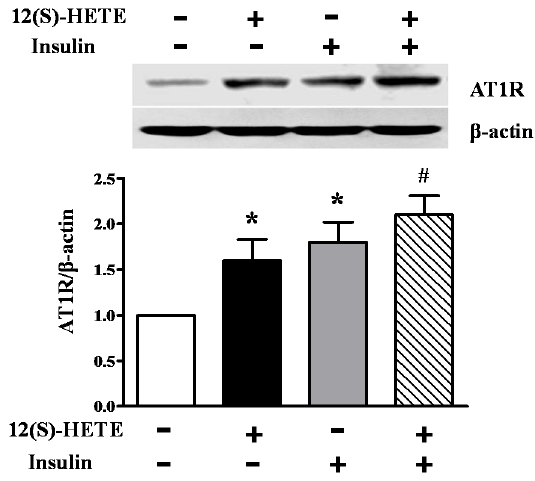
Figure 6. Effect of 12(S)-HETE and insulin on AT1R expression in rat MCs. Cultured rat MCs were stimulated with 12(S)-HETE or insulin for 24 h, and AT1R protein level was determined by Western blot. Data are presented as the mean ± SD of three independent experiments; * p < 0.01 vs. the control; # p < 0.05 vs. 12(S)-HETE or insulin.